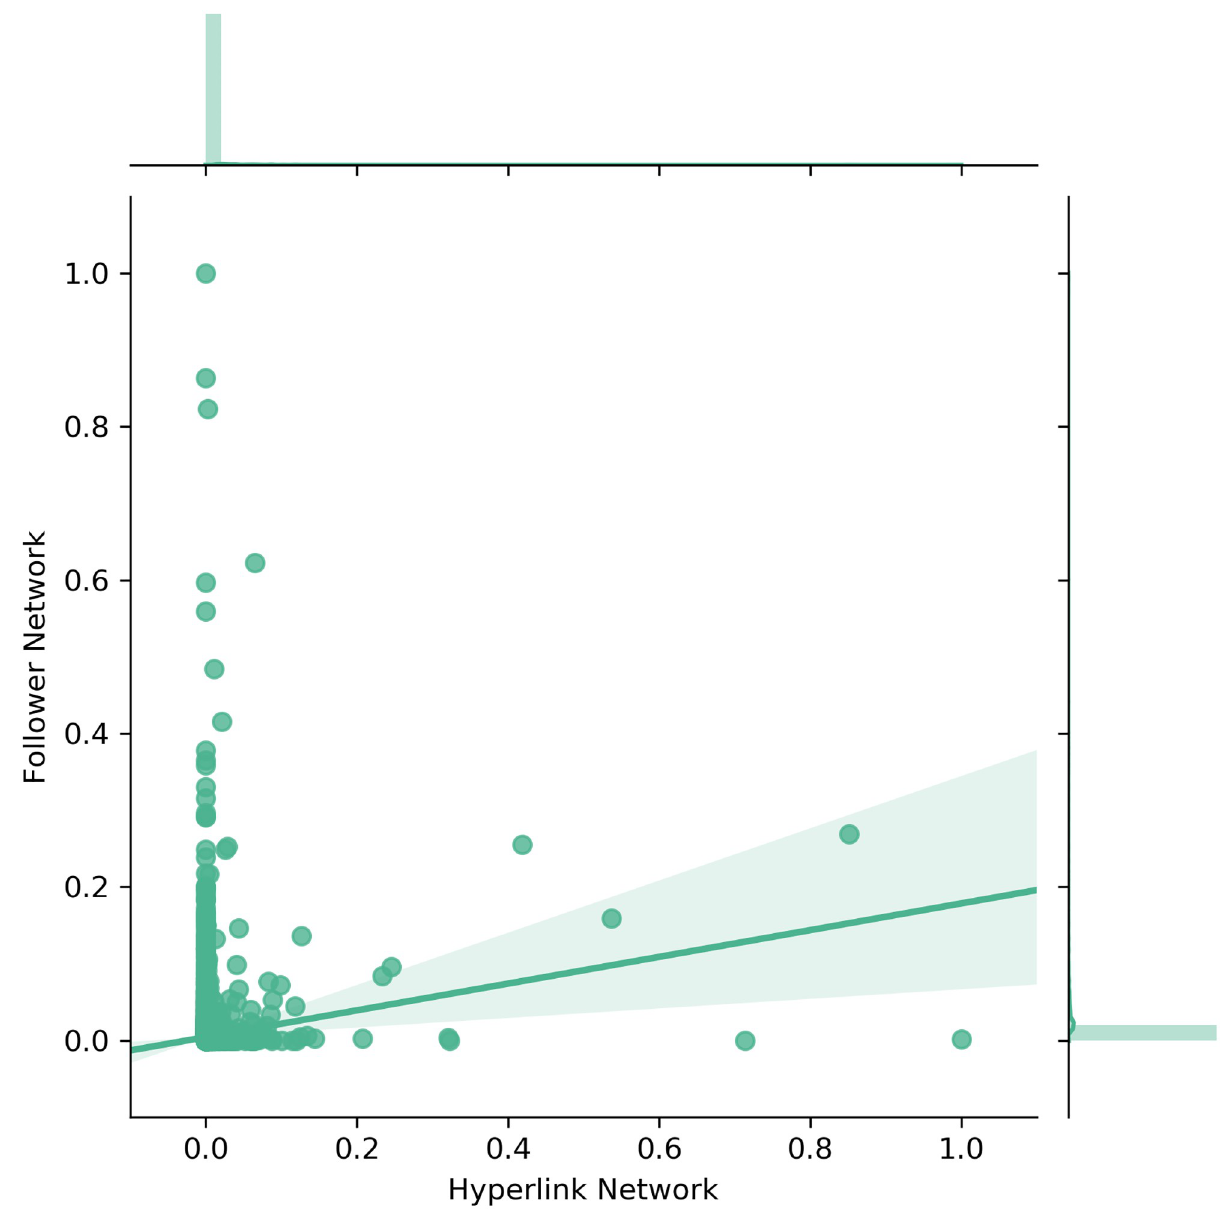
Fig 6. Scatter and density plots for betweenness